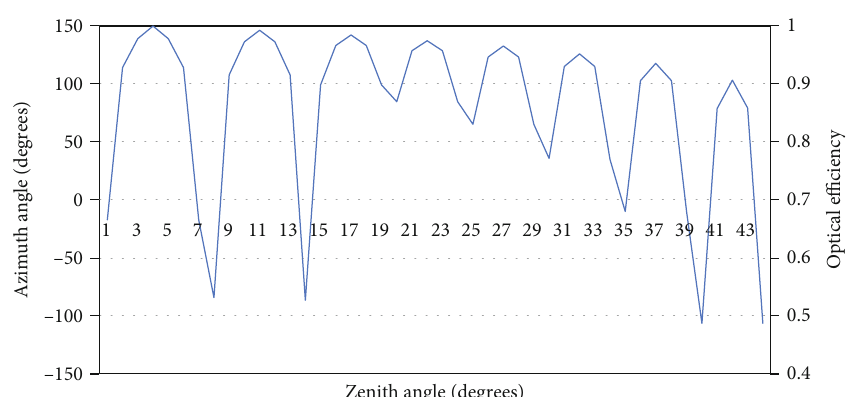
Figure 9: Optical e ffi ciency with respect to azimuth and zenith